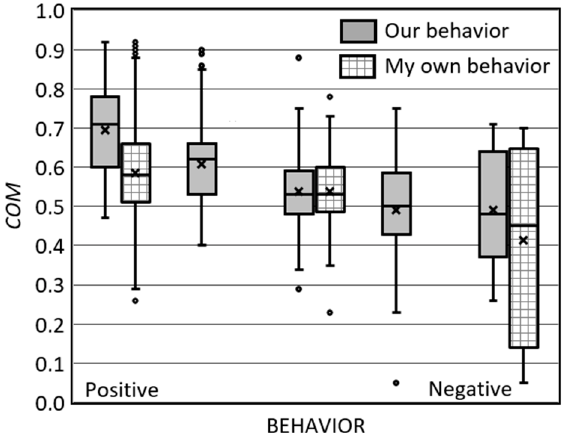
Figure 5. Capability-Opportunity-Motivation variable ( COM ) versus the self-reported energy-saving behavior of an individual (white hatched boxes—“my” behavior) and a group (grey boxes—“our” behavior).